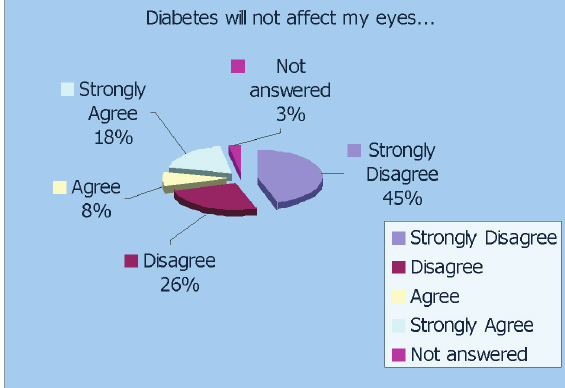
Figure 2. Patient views on the effects of diabetes on the eyes.